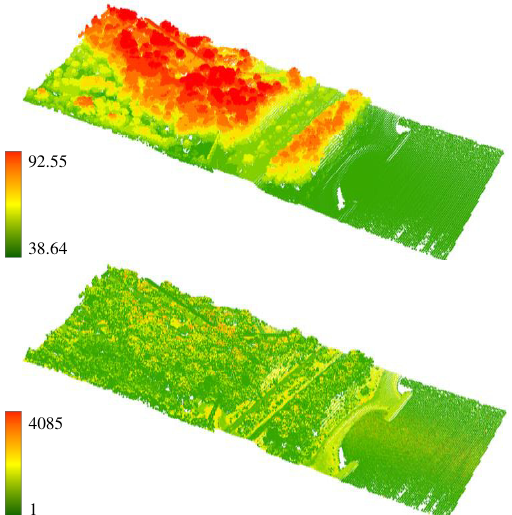
Figure 1. LiDAR point clouds from C2 for Site I (upper: height and lower: